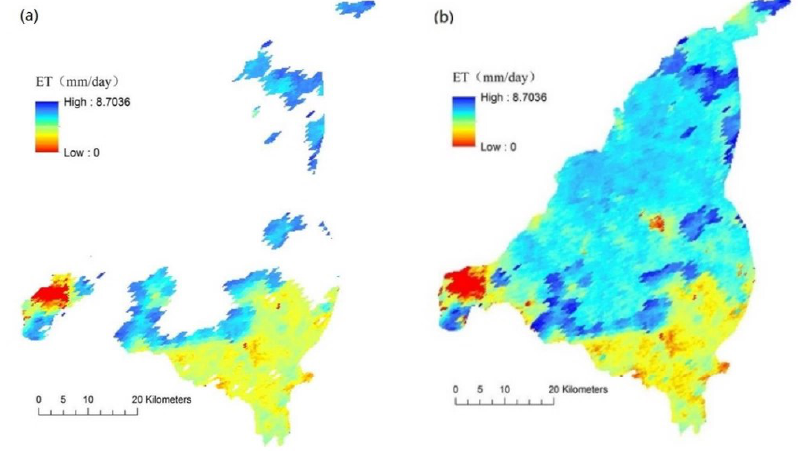
Figure 6. Spatial distribution of the ET on 13 August 2014. ( a ) before the interpolation; ( b ) after the